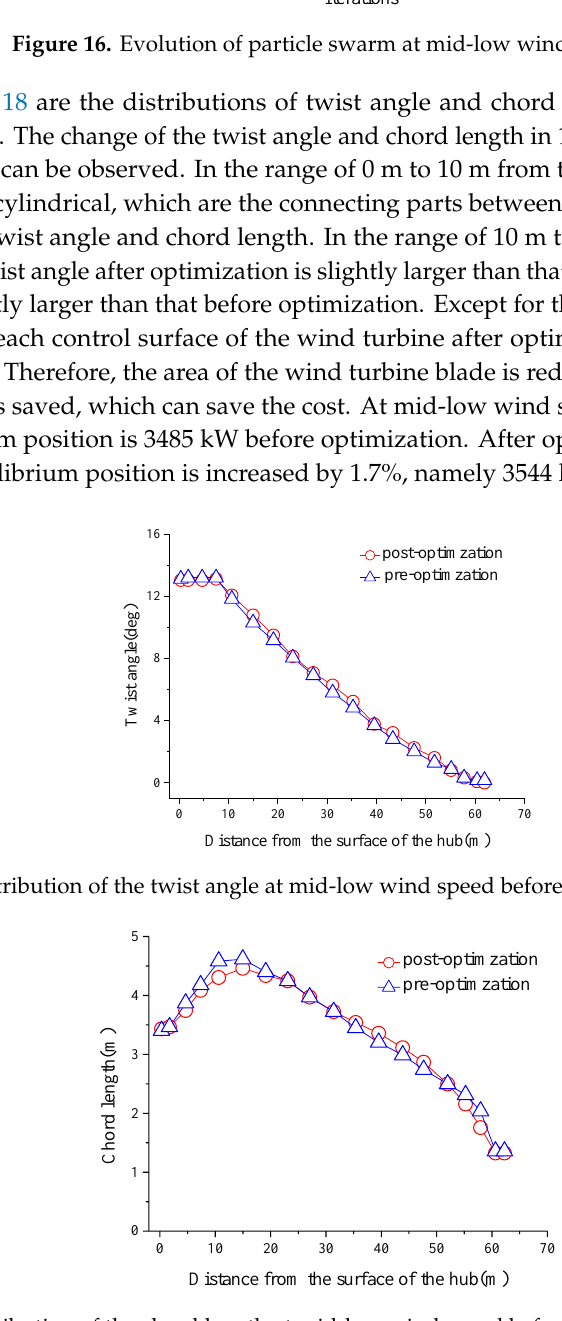
Figure 18. Distribution of the chord length at mid-low wind speed before and after optimization.